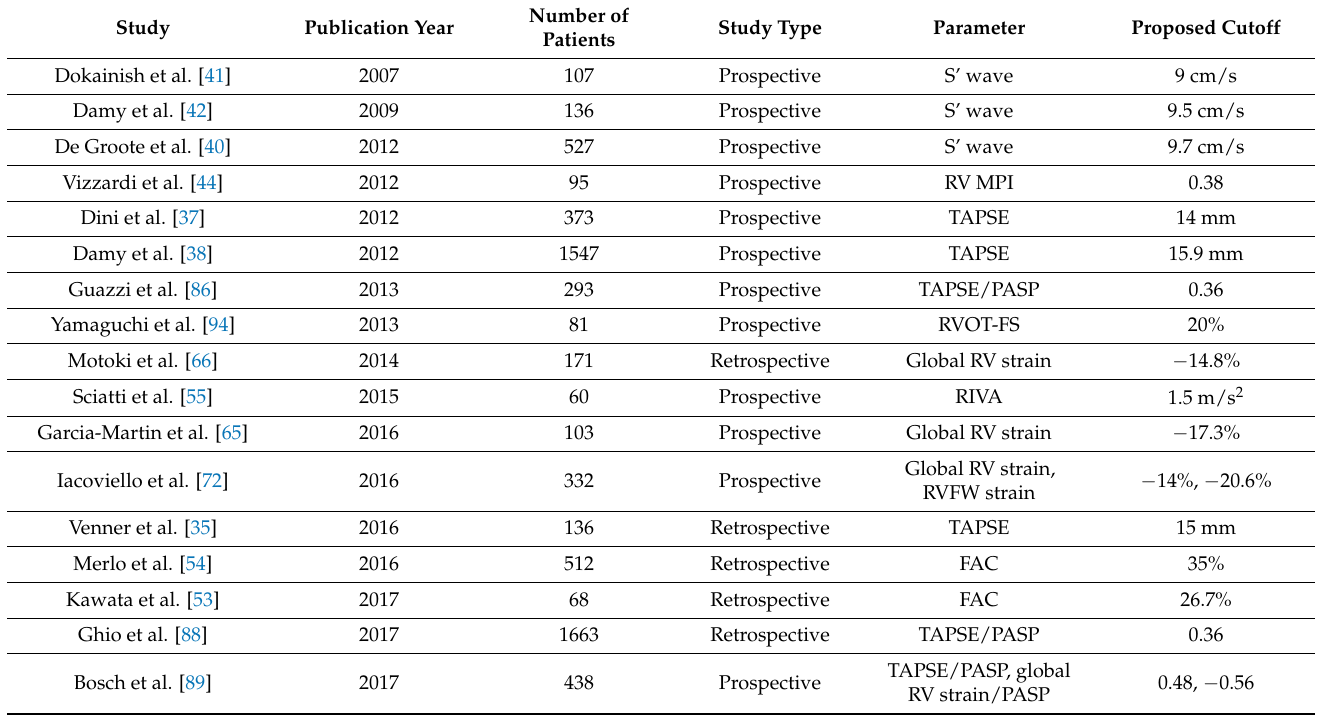
Table 1. Selection of studies demonstrating an independent prognostic role of RV functional parameters in patients with HF.